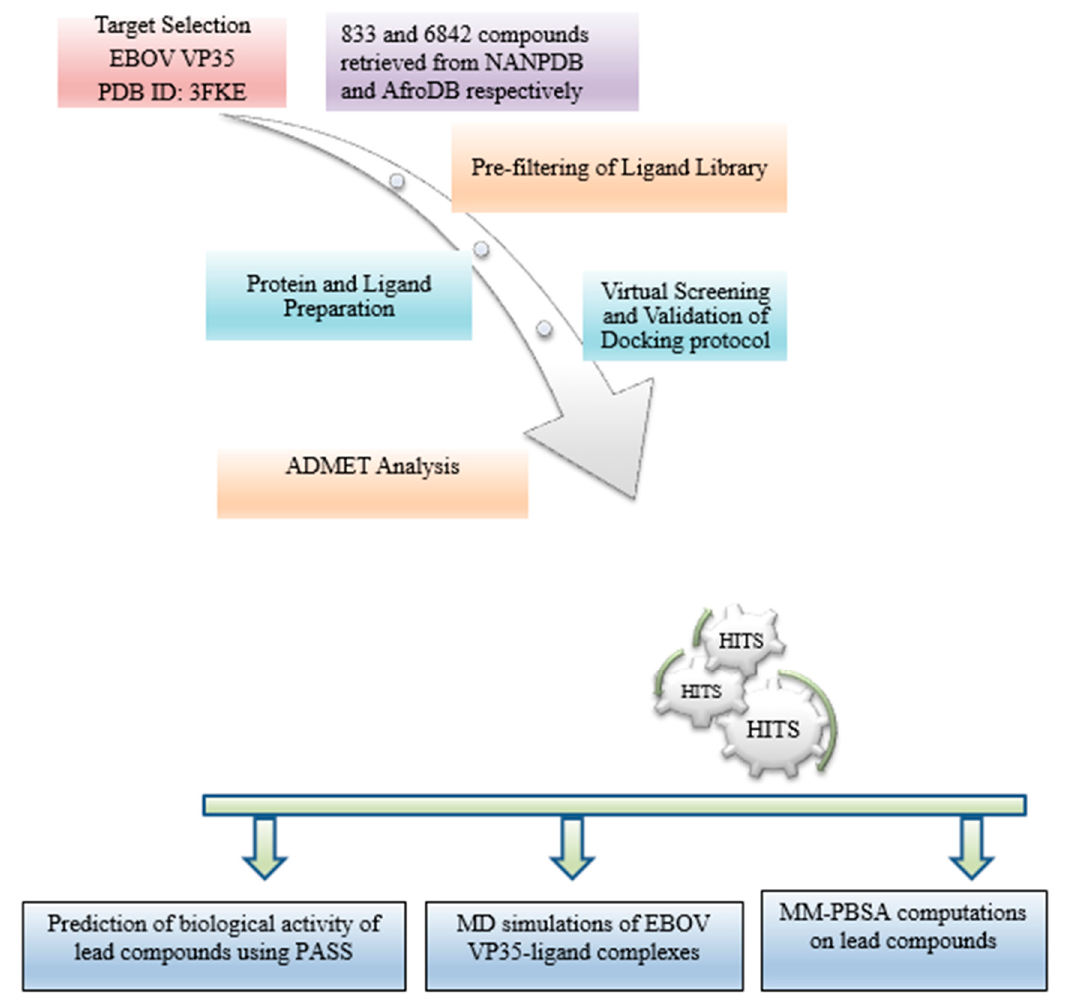
Figure 1. Detailed workflow used to implement this study. The methods involved in this study include molecular docking, analysis of intermolecular interactions, ADMET profiling, prediction of antiviral activity and molecular dynamics simulations.